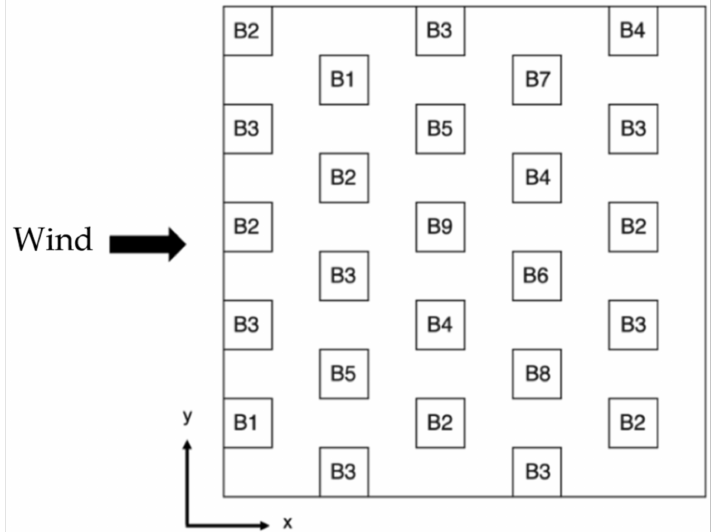
Figure 1. Plan view of the configuration of the random staggered array with wind flow in the x direction for λ p = 0.25 [24].